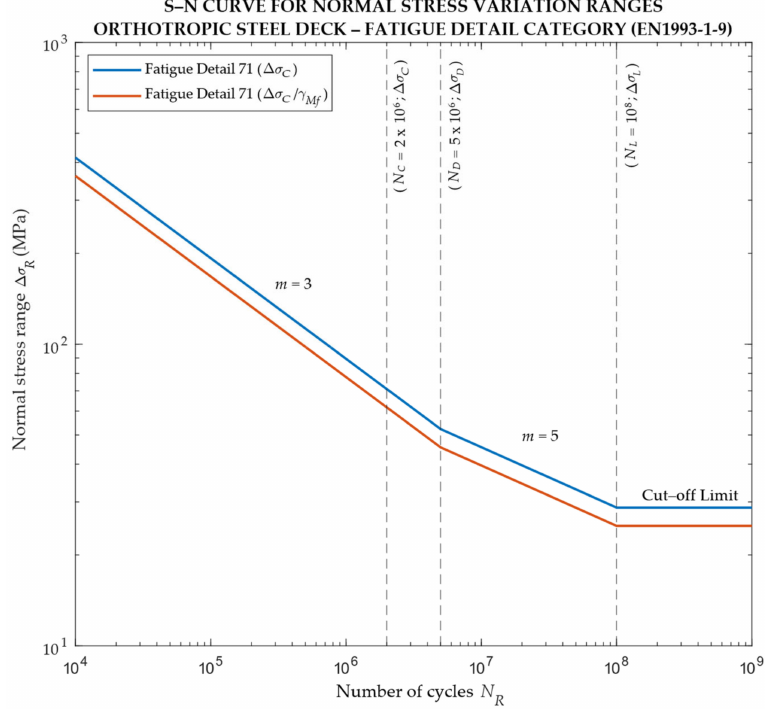
Figure 29. Design S-N curve for detail 71 from UNI EN 1993-1-9